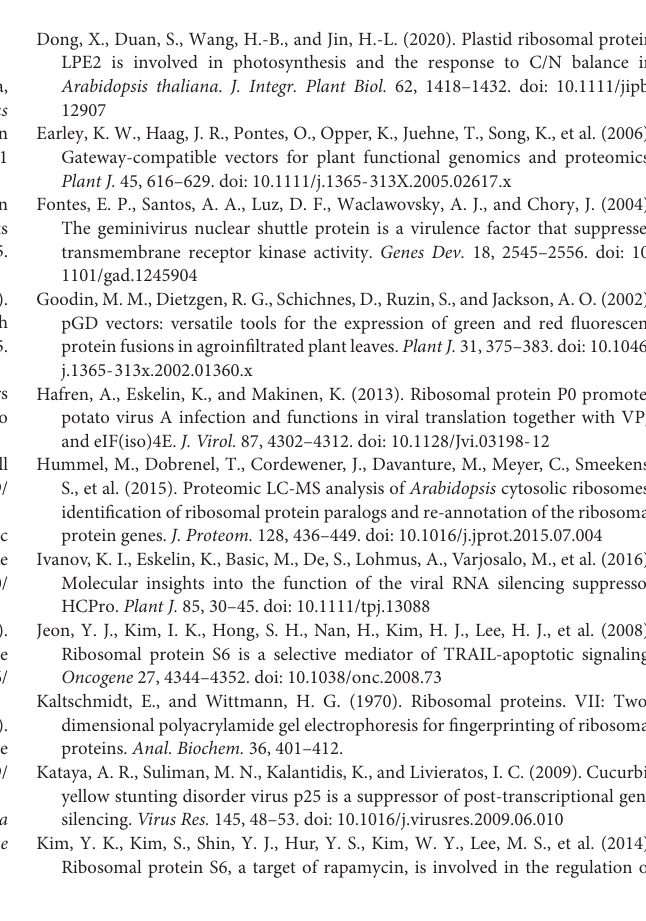
Supplementary Figure 5 | GFP fluorescence intensity of Figure 4D was measured using ImageJ2 software. Thirty independent images for each group were measured and values were statistically analyzed with t -tests. Three biological repeats were performed. Supplementary Table 1 | Primers used in the